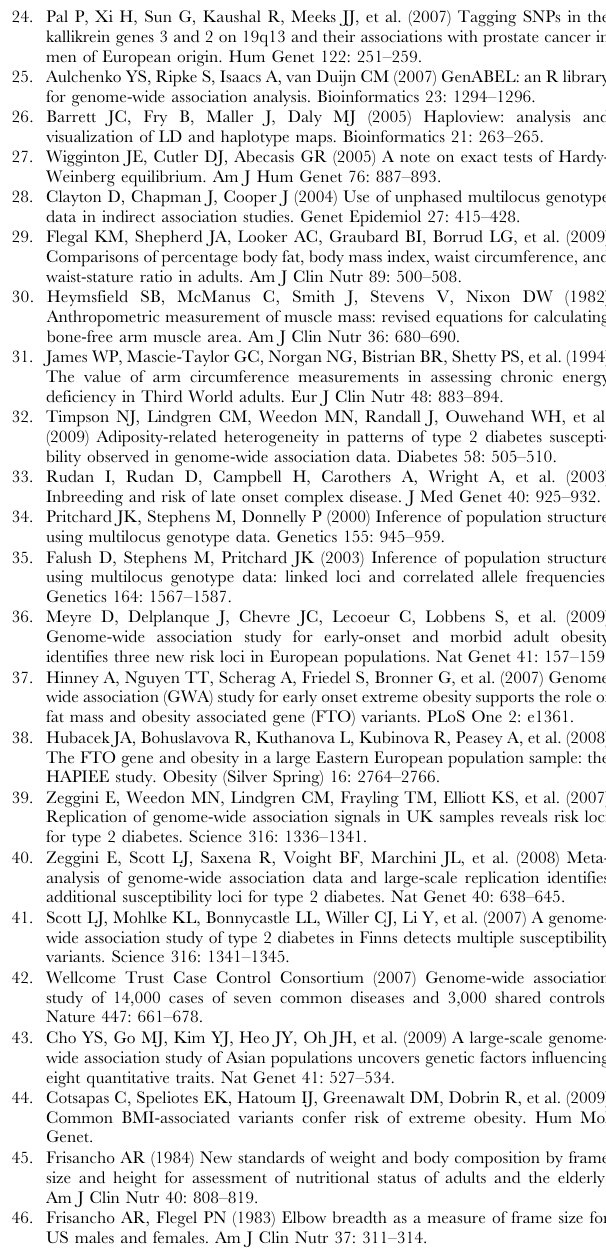
Table S3 Principle components of ‘‘body fatness’’ phenotypic measures.